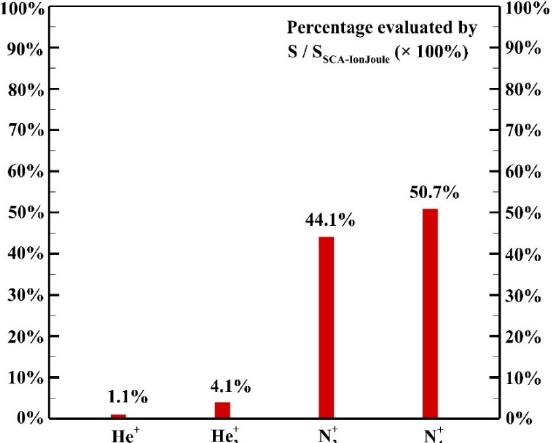
Figure 12. The contribution of each species to the ion Joule heating.